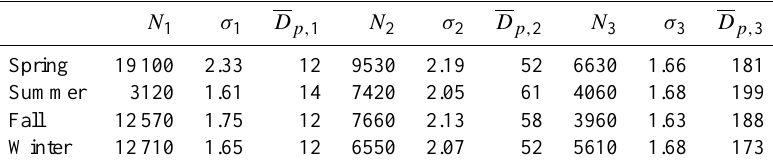
Table 2. Parameterization of Particle Number Size distribution for four seasons. The D p,i , σ i and N i represent the geometric mean diameter, geometric standard deviation and mean number concentration. Here i =1, 2, 3 corresponds to nucleation mode, Aitken mode and accumulation mode, respectively.